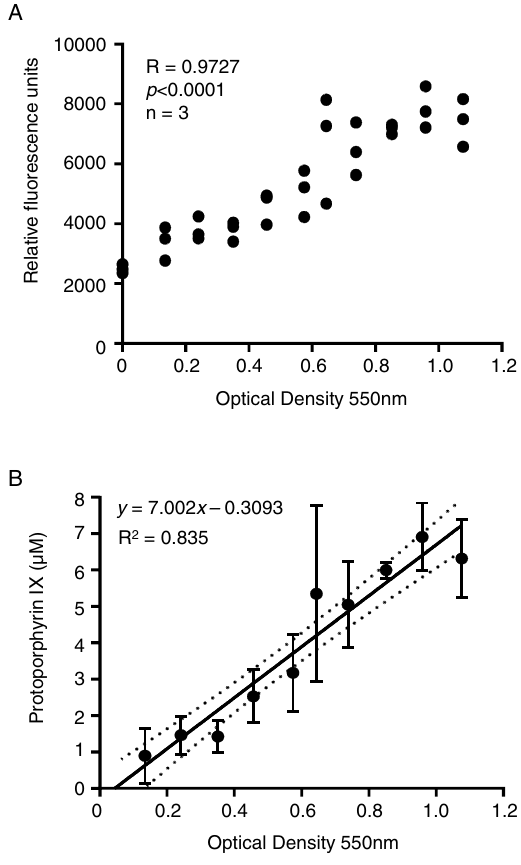
Figure 3. PpIX quantity in P . gingivalis . ( A ) Correlation of the relative fluorescence units and P . gingivalis concentration change (n = 3). ( B ) Linear regression between the concentration of P . gingivalis and PpIX (n = 3). Dots represent the 95% confidence curve.